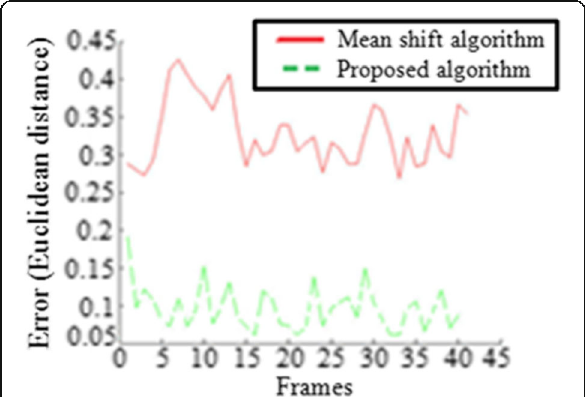
Fig. 17 Tracking error graph of CAVIAR database set (image sequences of Fig.